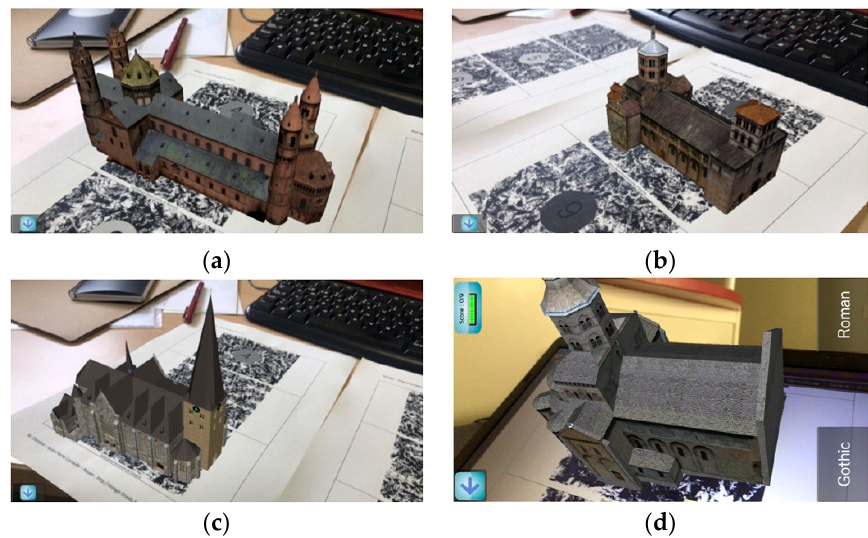
Figure 1. TheappArquitecturegotique / Figure 1. The app Arquitecture gotique/romane in action, which is accessed by scanning downloadable codes.